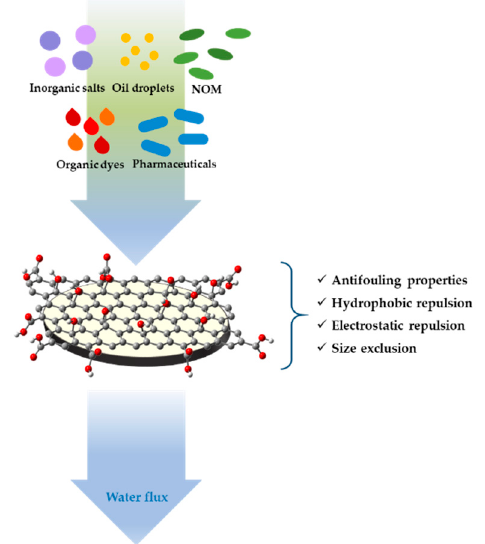
Figure 7. Schematic representation of water contaminants retention of graphene oxide (GO) coated ultrafiltration (UF) membrane.